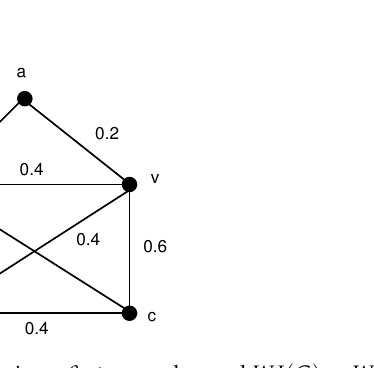
Figure 2. uv is an β -strong edge and WI ( G ) = WI ( G − uv ) .